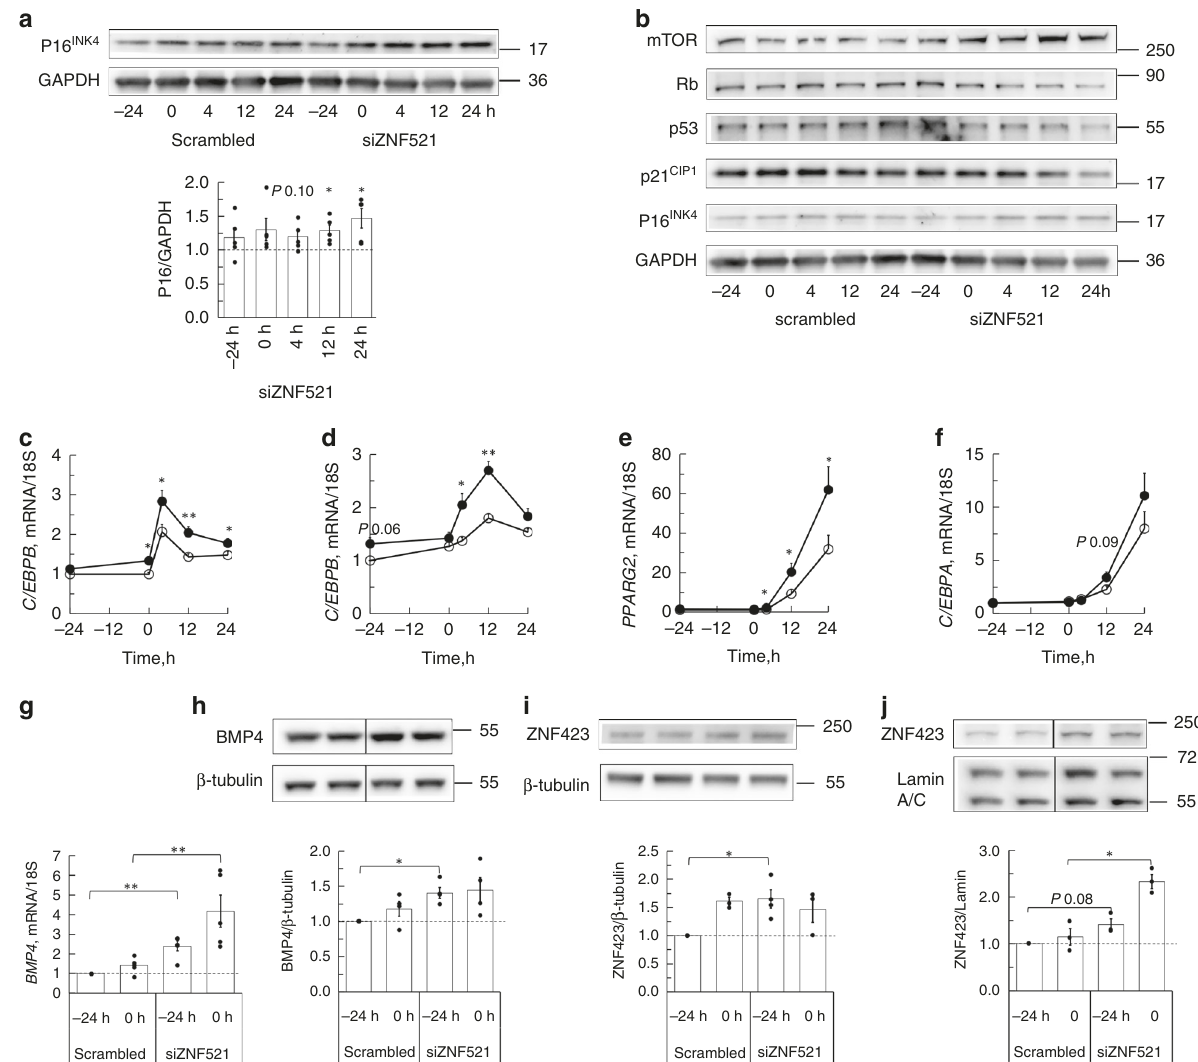
Fig. 3 Silencing ZNF521 activates progenitor cell commitment and induces expression of early adipogenic factors. Silencing of ZNF521 was performed 72 h before initiation of differentiation (0 h). a Immunoblot of P16 INK4 after silencing ZNF521. Immunoblots from one individual. Graph shows normalization to scrambled cells at the same time point, n = 4 independent experiments, mean ± SEM. Paired two-tailed Student ′ s t -test was used for comparison with scrambled cells. b Immunoblots showing cell cycle proteins. Representative immunoblots from one individual of four. c – f Expression of the early adipogenic genes. Paired two-tailed Student ′ s t -test was used for comparison of silenced with scrambled cells. Data represent means± SEM * P < 0.05 and ** P < 0.01 n = 5 independent experiments. g Induction of BMP4 when ZNF521 is silenced. Data represent means ± SEM, n = 5. g – j mRNA results were fi rst normalized to 18 S and then normalized to expression levels in the undifferentiated scrambled cells at -24 h before initiation of differentiation. h Immunoblots of BMP4, n = 4 independent experiments and i ZNF423 in whole cell lysates, n = 4 independent experiments and j in nuclear extracts, n = 3 independent experiments. g – j Paired two-tailed Student ′ s t -test was used for comparison of silenced with scrambled cells. * P < 0.05 and ** P <